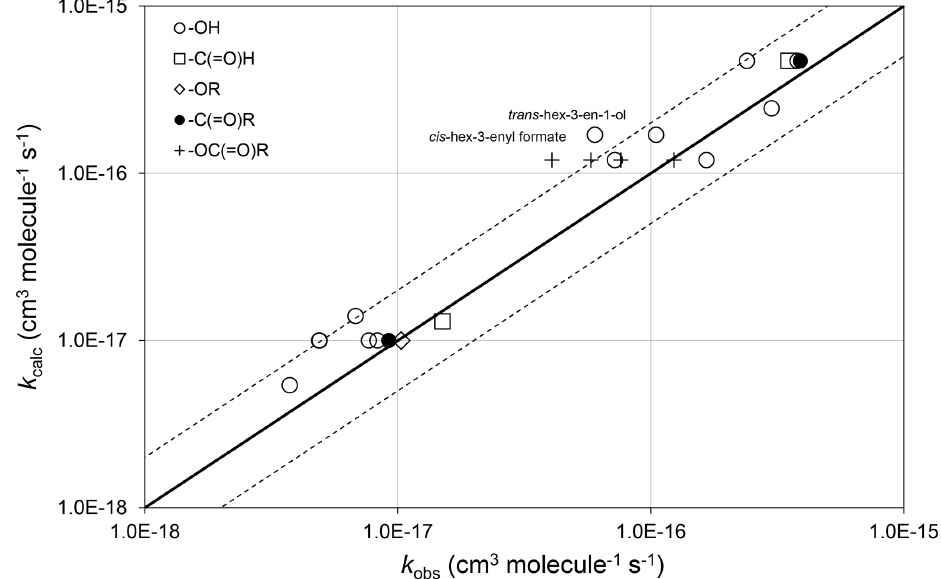
Figure 4. Scatter plot of observed and calculated values of k at 298K for the reactions of O 3 with oxygenates containing remote oxygenated groups as shown (see Sect. 4.2). The broken lines show the factor-of-2